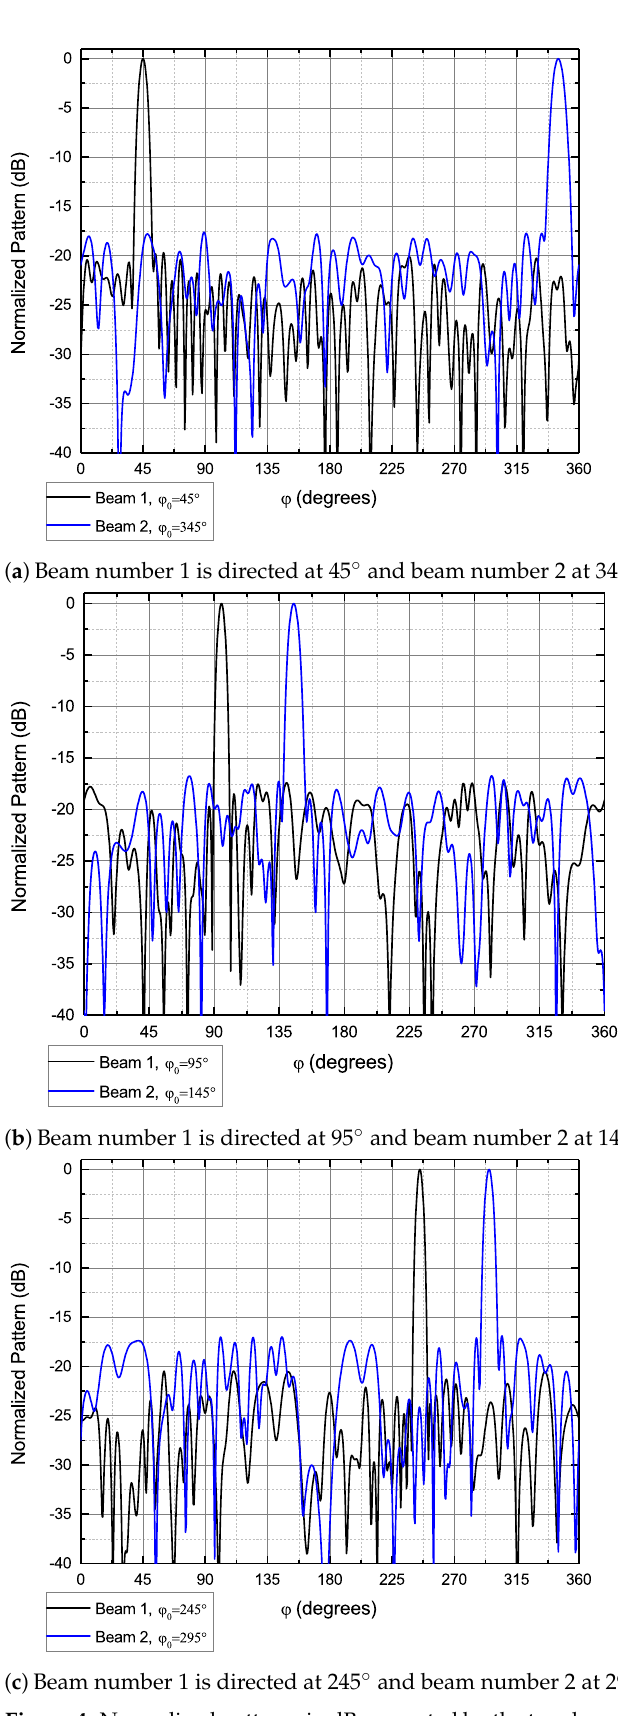
Figure 4. Normalized patterns in dB generated by the two-beam feeding network with a non-uniform CCRA optimized using differential